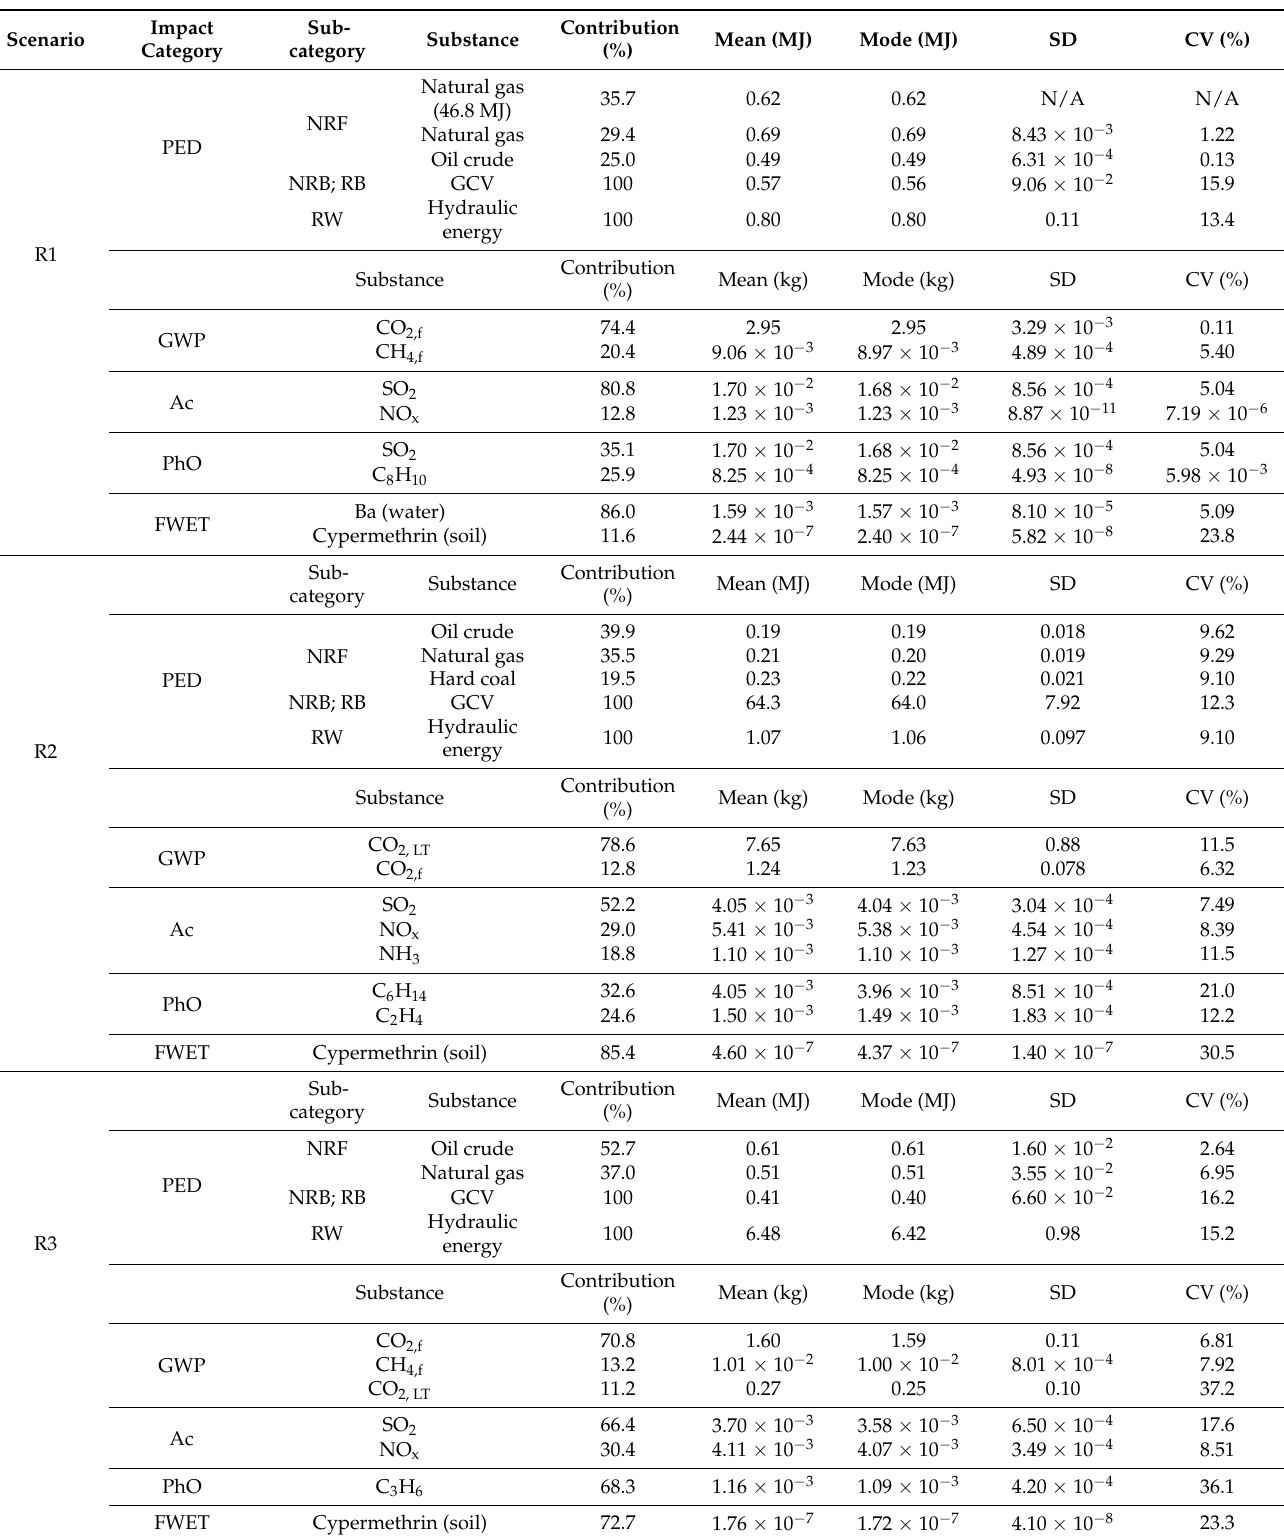
Table 4. Results of the Monte Carlo simulation for the environmental models concerning the